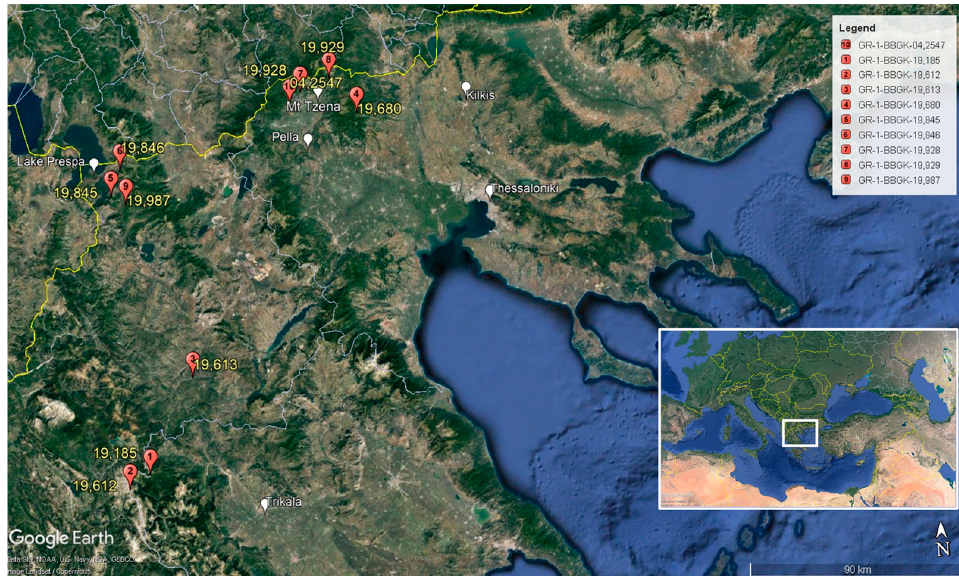
Figure 7. Geographical distribution of Greek native Amelanchier ovalis subsp. ovalis wild-growing populations sampled across northern Greece. The last 5 or 6 digits of the IPEN accession number are given for each population on the map, with full IPEN accession numbers shown in the legend. For localities, geographical coordinates, collection details, and types of collected material see Table